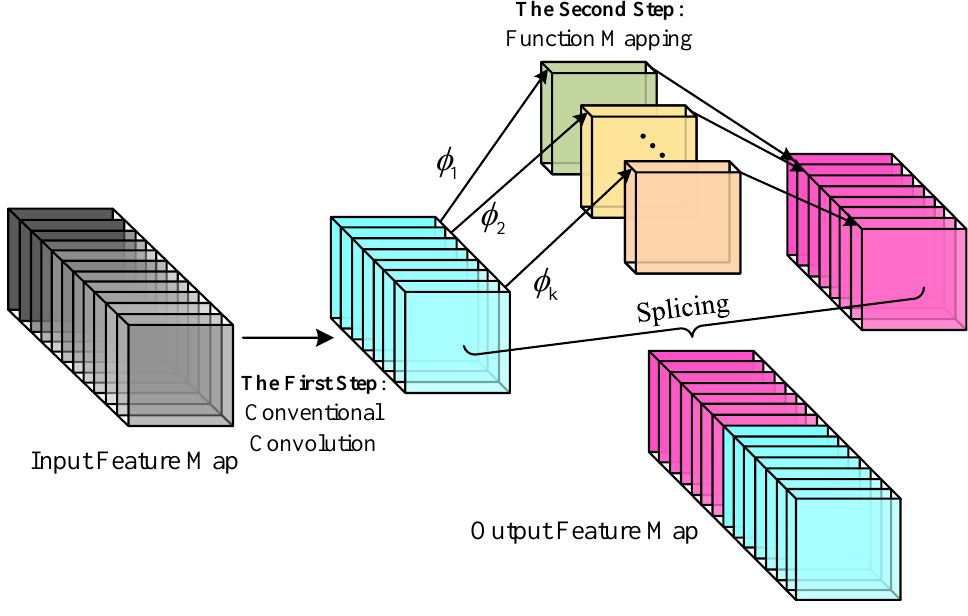
Figure 7. Intrinsic feature mapping module detailed